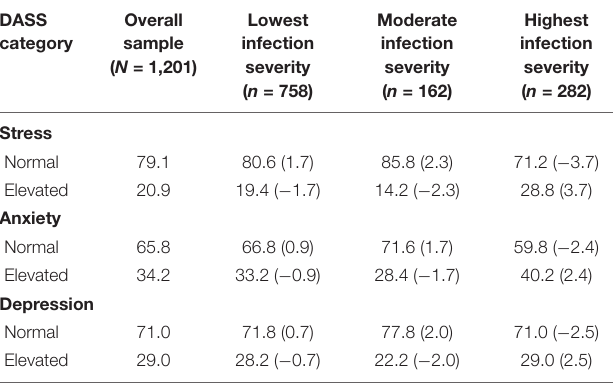
TABLE 5 | Percentage of participants displaying normal and elevated levels of stress, anxiety, and depression by infection severity of region of residence, along with adjusted standardized residuals for cells (in brackets).